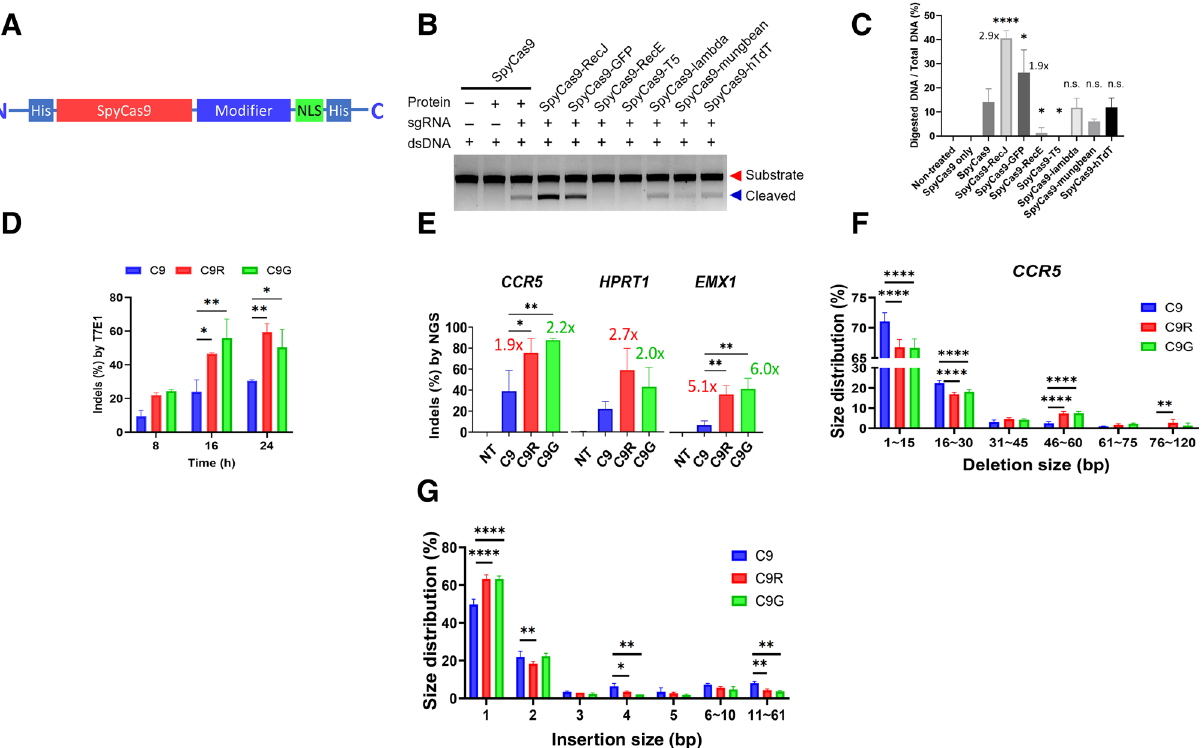
Figure 1. Marked increase in indel efficiency of the Cas9-RecJ and Cas9-GFP chimeric fusion proteins. ( A ) Schematic of a translational fusion of a modifier protein to SpyCas9. His tag (6X His) for protein purification and nuclear localization signal (NLS) were placed. ( B ) Comparison of the DNA cleavage activity of SpyCas9 and its chimeric proteins, C-terminal chimeric SpyCas9 translational fusion proteins with the nucleases RecJ, RecE, T5, lambda, mung bean exonuclease, and human terminal deoxynucleotidyl transferase (TdT), and with green fluorescent protein (GFP). The modifier proteins are described in Supplementary Table 1. The CCR5 DNA was digested with the purified enzymes and resolved on an agarose gel. Successful digestion cuts the 1.5 kb substrate DNA into two 0.75 kb DNAs. ( C ) DNA band intensities in the gel image. Statistical comparison was made between C9 and each of the C9R or C9G proteins. Significance was indicated on top of each bar. One-way ANOVA using Tukey’s multiple-comparison test. The fold change relative to C9 is indicated above each bar. ( D ) DNA insertion and deletion (Indel) efficiency of C9, C9R, and C9G for the CCR5 gene in HEK293T cells at 8, 16, and 24 h after RNP transfection as measured by a T7E1 assay. Averages from the three replicate experiments are plotted. Two-way ANOVA using Tukey’s multiple-comparison test. ( E ) Indel efficiency of C9, C9R, and C9G for the CCR5 , HPRT1 , and EMX1 genes (left to right) in HEK293T cells. At 24 h ( CCR5 and HPRT1 ) and 8 h ( EMX1 ) post-transfection, cells were harvested and subjected to targeted deep sequencing. The experiments were performed in triplicate. NT group represent the NGS data from non-treated control. One-way ANOVA using Tukey’s multiple-comparison test was performed using C9 data as control. ( F ) Distribution of the DNA deletion sizes after treatment with C9, C9R, and C9G. The number of deletion events around the protospacer site in the CCR5 gene was counted according to the 15 bp deletion intervals from targeted deep sequencing data (n = 3) data. ( G ) Distribution of DNA insertion sizes after treatment with C9, C9R, and C9G in the CCR5 gene. The number of insertion events was counted according to the 1 bp insertion intervals from targeted deep sequencing data (n = 3) data. 6–10 and 11–61 bp insertion intervals were also shown to include events with smaller numbers. **** P < 0.0001, *** P < 0.001, ** P < 0.01, * P < 0.05, and n.s. indicates not